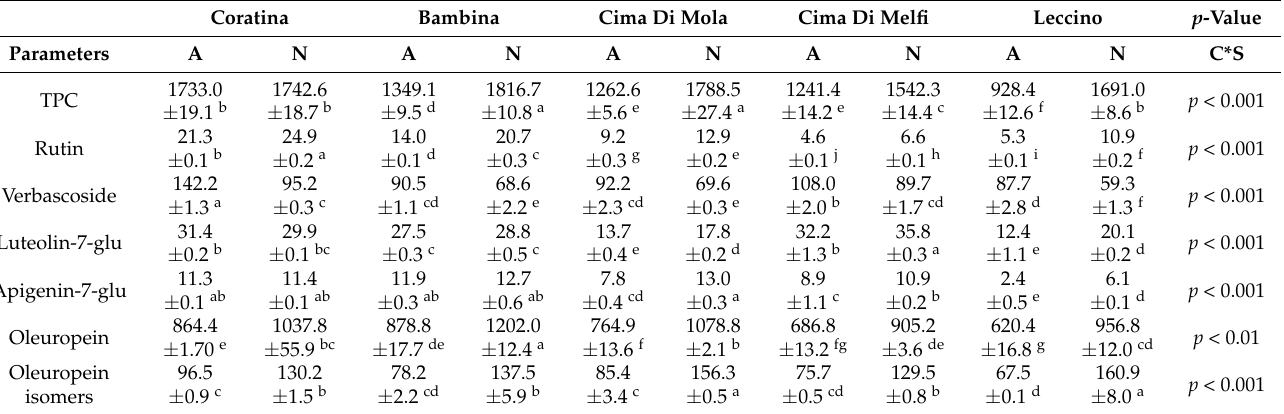
Table 2. Total phenol content determination and main phenolic compounds’ quantitation by